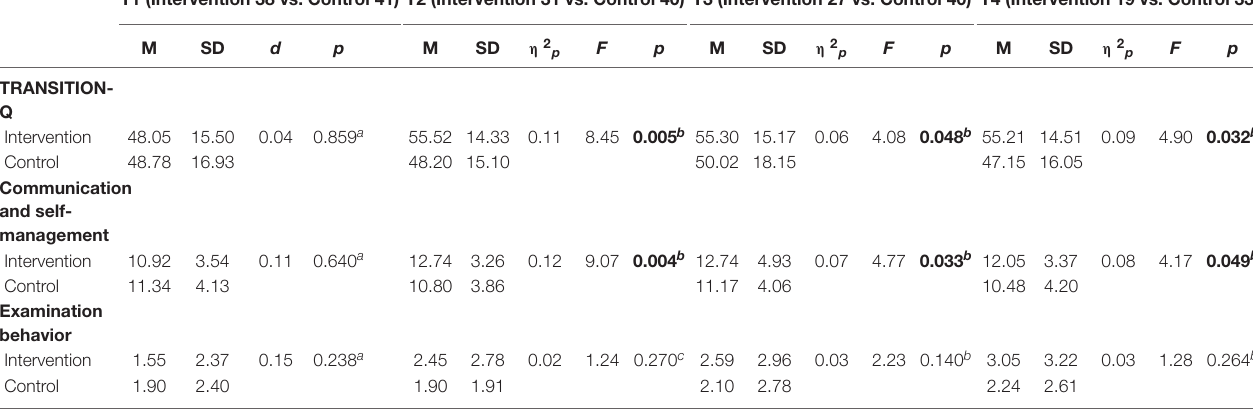
TABLE 2 | Differences in Transition Readiness as measured by the